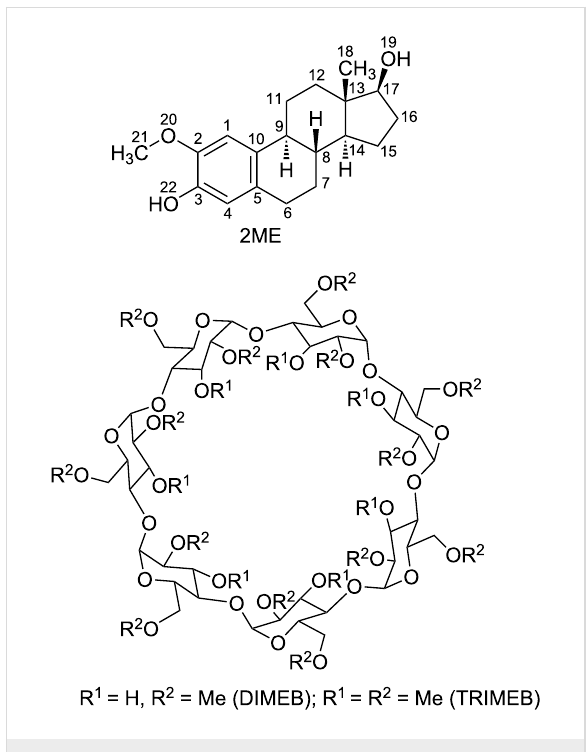
Figure 1: Chemical structures of 2-methoxyestradiol (top) and the derivatised CDs DIMEB and TRIMEB (bottom).